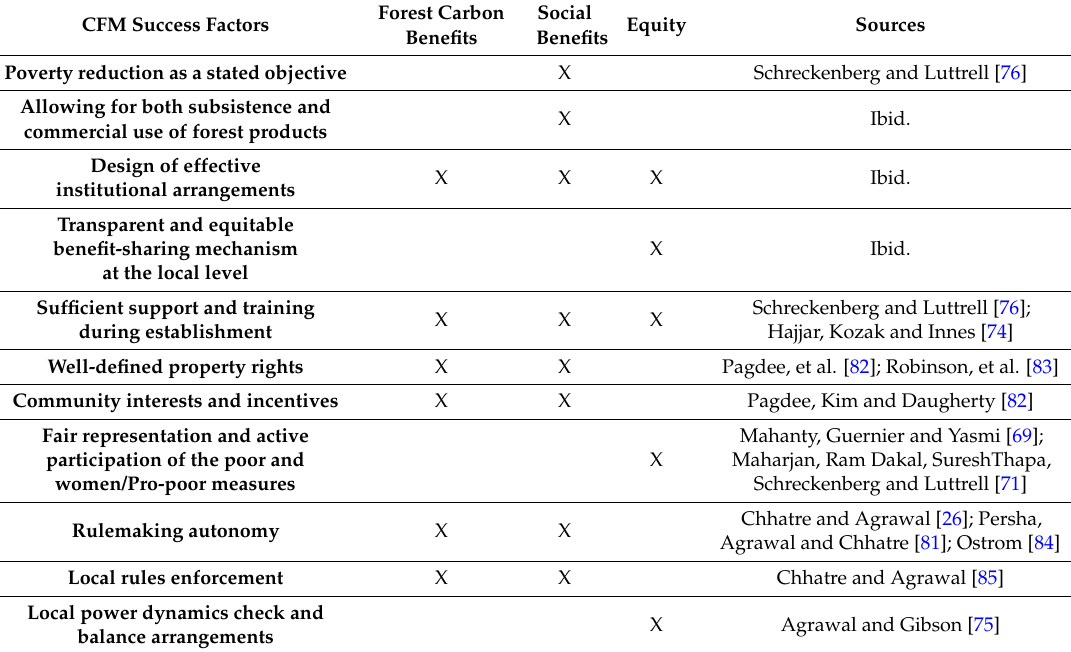
Table 4. Criteria identified under CFM for assessing successful outcomes with relevance for REDD+ implementation at the community